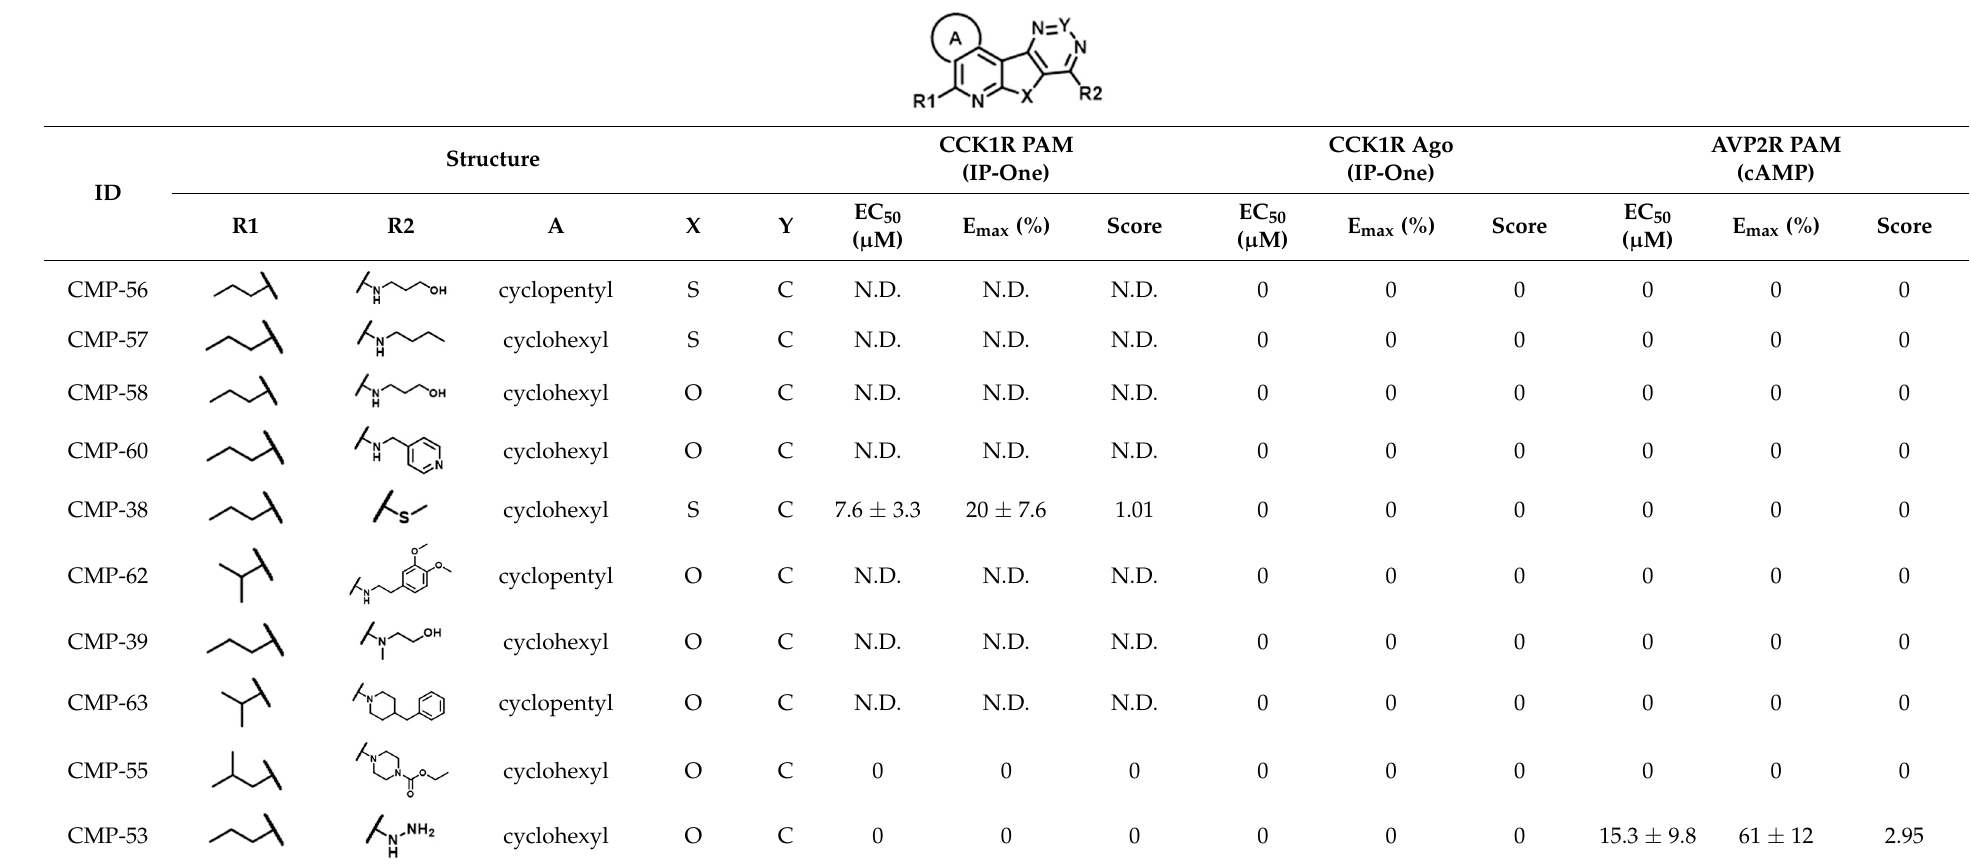
Average potencies (EC 50 (µM) ± standard deviation (SD)), average compound efficacy (E max (%) ± SD), and calculated activity score (E max × pEC 50 ) of compound dose–response studies in screening mode. Compounds were tested in Cisbio IP-One and cAMP accumulation assays; N.D. = not deter- minable (response less than mean ± 3 × SD of negative control). Table 6. Structure–activity studies of 10 n -alkyl analogs. Table 6. Structure–activity studies of 10 n -alkyl Table 6. Structure–activity studies of 10 n -alkyl analogs. Table 6. Structure–activity studies of 10 n -alkyl analogs. Table 6. Structure–activity studies of 10 n -alkyl analogs. Table 6. Structure–activity studies of 10 n -alkyl analogs. Table 6. Structure–activity studies of 10 n -alkyl analogs. Table 6. Structure–activity studies of 10 n -alkyl analogs. Table 6. Structure–activity studies of 10 n -alkyl analogs. Table 6. Structure–activity studies of 10 n -alkyl analogs. Table 6. Structure–activity studies of 10 n -alkyl analogs. Table 6. Structure–activity studies of 10 n -alkyl analogs. Table 6. Structure–activity studies of 10 n -alkyl analogs. Table 6. Structure–activity studies of 10 n -alkyl analogs. Table 6. Structure–activity studies of 10 n -alkyl analogs. Table 6. Structure–activity studies of 10 n -alkyl analogs. Table 6. Structure–activity studies of 10 n -alkyl analogs. Table 6. Structure–activity studies of 10 n -alkyl analogs. Table 6. Structure–activity studies of 10 n -alkyl analogs. Table 6. Structure–activity studies of 10 n -alkyl analogs. Table 6. Structure–activity studies of 10 n -alkyl analogs.